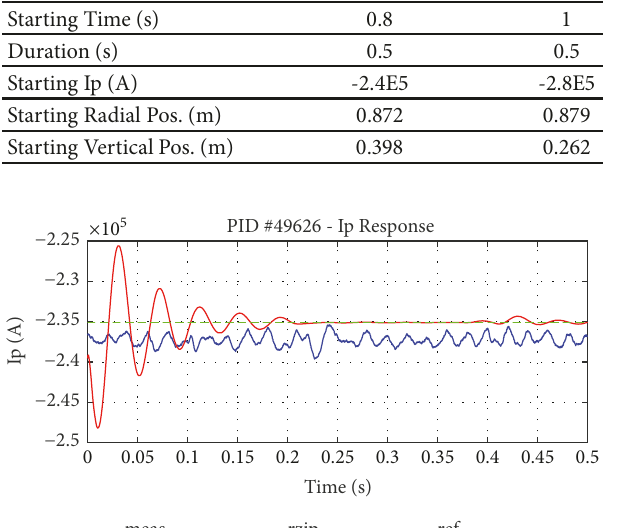
Figure 7: PID Response (Shot #49626).